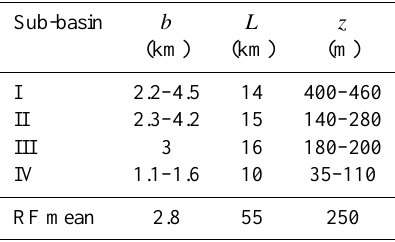
Table 1. Topographic features of the sub-basins in the Reloncaví fjord (RF). Here, b is the width, L is the length, and z is the depth.